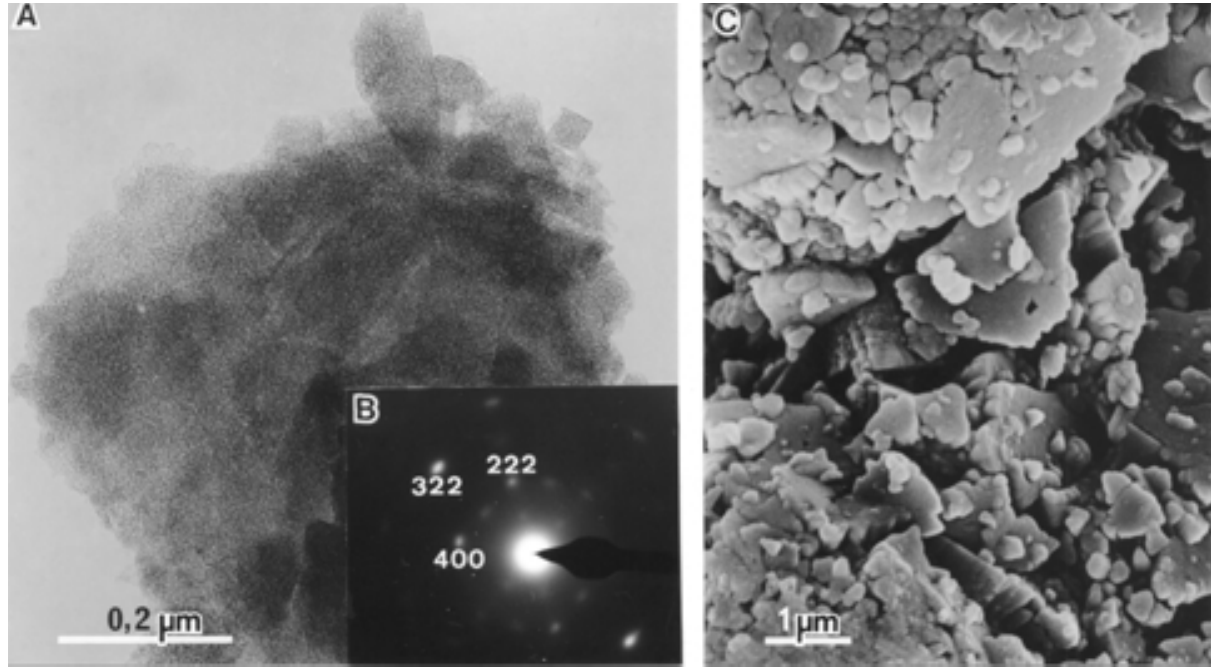
Figure 8. eta-Al 2 0 3 (A) - Transmission electron micrograph; (B) - selected area electron diffraction pattern; (C) scanning electron